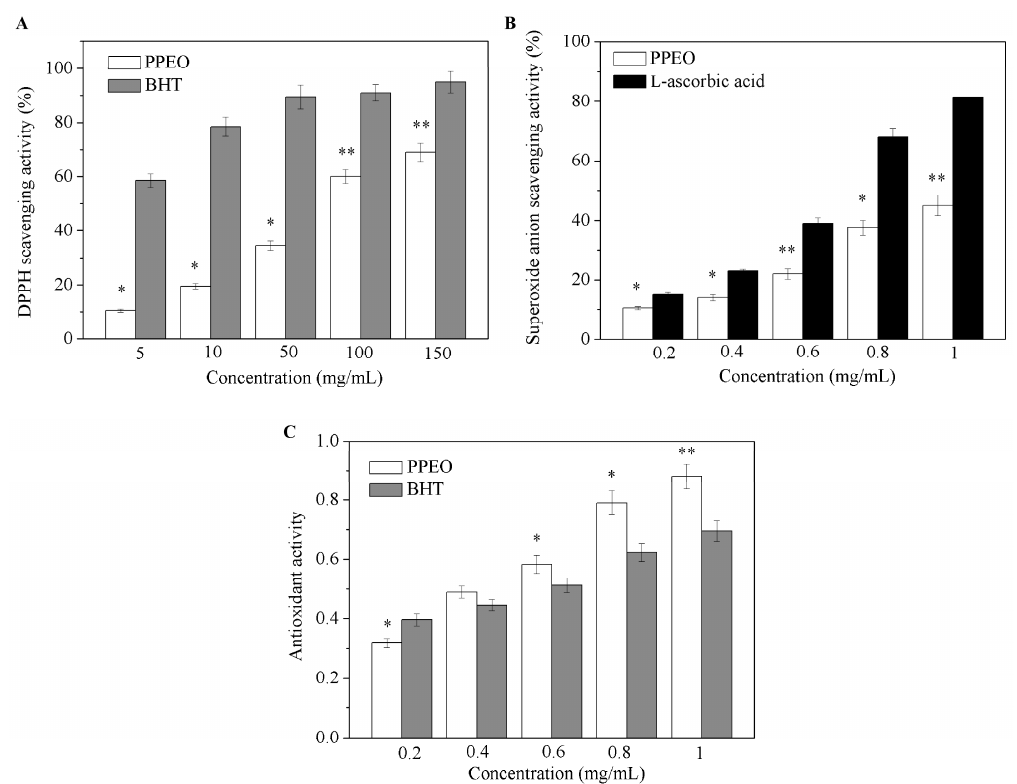
Figure 2. Antioxidant activities of PPEO. ( A ) 1,1-Dipheny-2-Picryhydrazyl (DPPH) radical scavenging assay; ( B ) superoxide anion radical scavenging activity assay; ( C ) 2,2'-azinobis-(3- ethylbenzthiazoline-6-sulphonate) (ABTS) total antioxidant activity. * Indicates samples that are significantly different ( n = 3; * p < 0.05 and ** p < 0.01 compared with the positive control group).